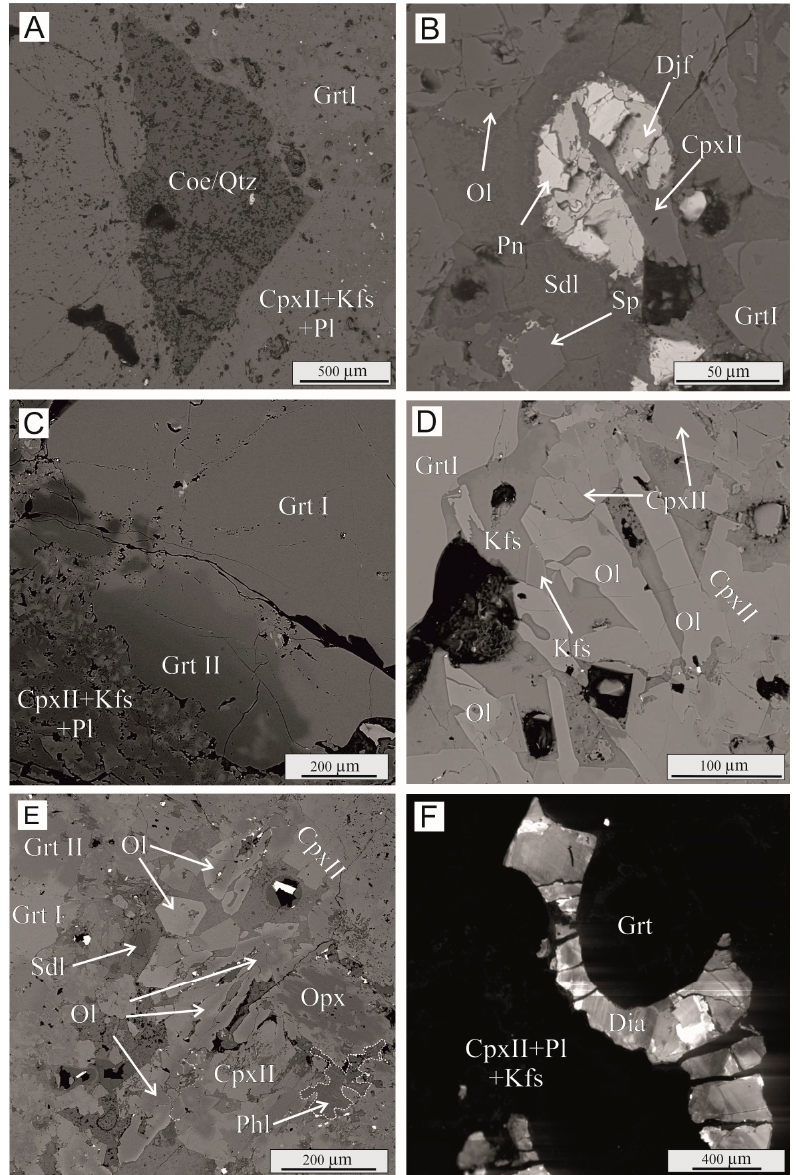
Figure 5. Images of sample Uv-537. ( A ): coesite grain with quartz rim (Coe / Qtz) in intergranular space (Grt I—garnet core, CpxII—secondary clinopyroxene, Pl—plagioclase, Kfs—K-feldspar); ( B ): sulfides (Pn—pentlandite, Djf—djerfisherite) with secondary clinopyroxene, sodalite (Sdl), spinel (Sp) and olivine (Ol) in intergranular space); ( C ): garnet grain with prominent core to rim (Grt II) zoning; ( D ): olivine grains with secondary minerals in intergranular space; ( E ): orthopyroxene-olivine intergrowth with secondary mineral assemblages (Opx—orthopyroxene, Phl—phlogopite) between garnet and symplectite after omphacite; ( F ): boundary between diamond (Dia) [84] and symplectite after omphacite. ( A – E ): BSE images, ( F ): cathodoluminescence topogram.